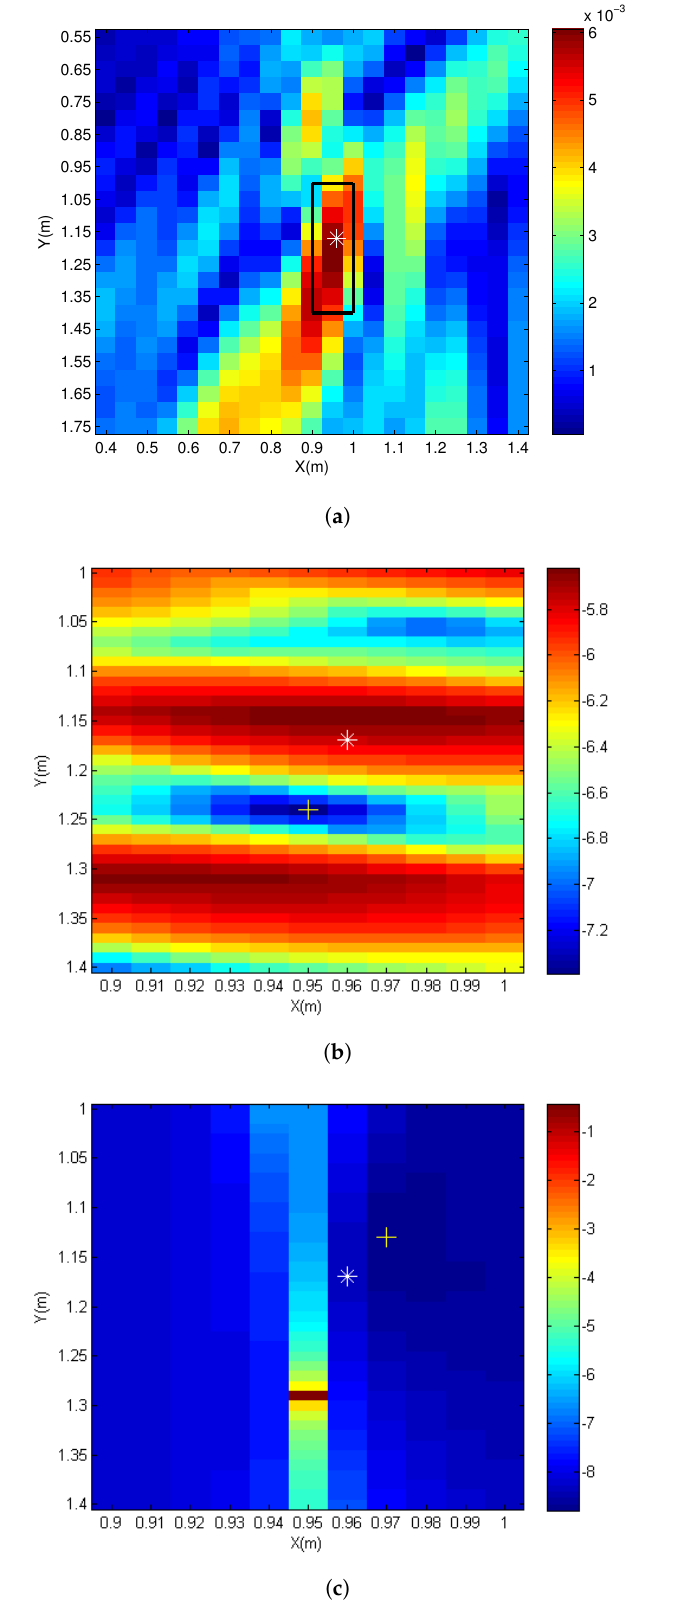
Figure 4. Localization results of the RF-SML algorithm. ( a ) The coarse-grained localization. ( b ) The fine-grained localization without phase correction. ( c ) The fine-grained localization with phase correction. The black outline indicates the high probability region of the tag. The white asterisk and the yellow cross represent the estimated position and the ground truth,